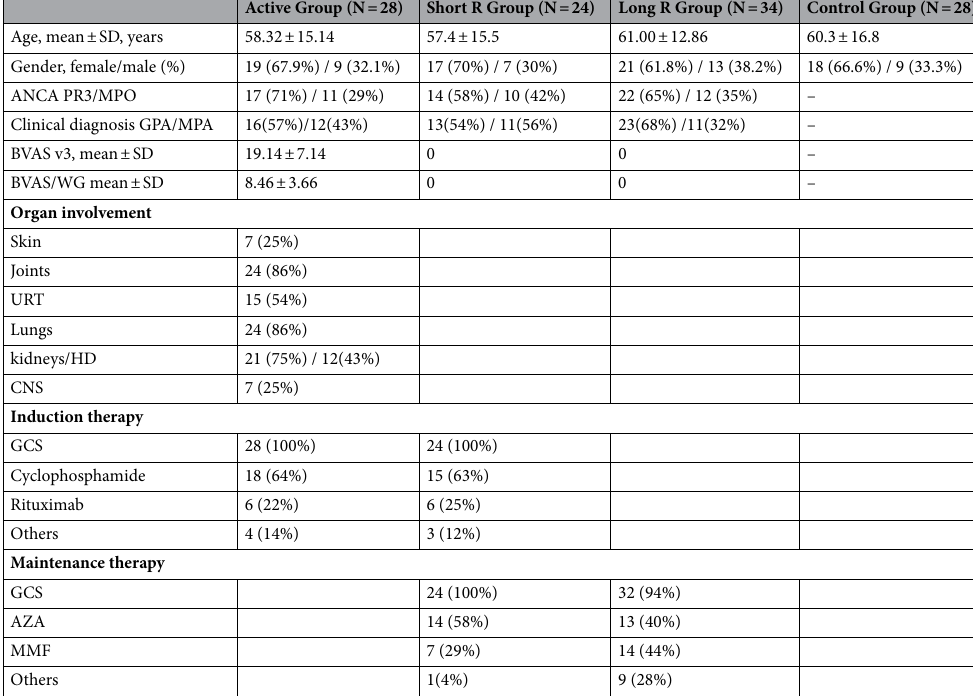
Table 1. Clinical characteristics of the study population. GCS glucocorticosteroids, GPA granulomatosis with polyangiitis, MPA microscopic